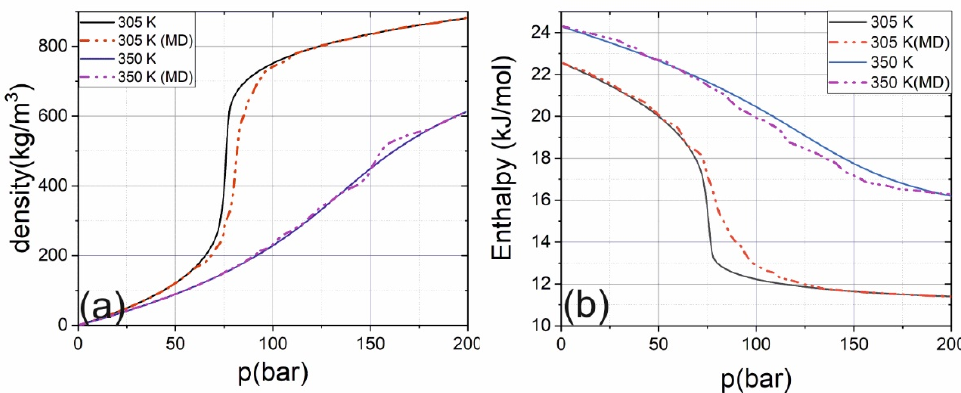
Figure 9. Dependence of computed (dash-dot lines) and tabular (solid lines) values of density ( a ) and enthalpy ( b ) on pressure for CO 2 different temperatures.